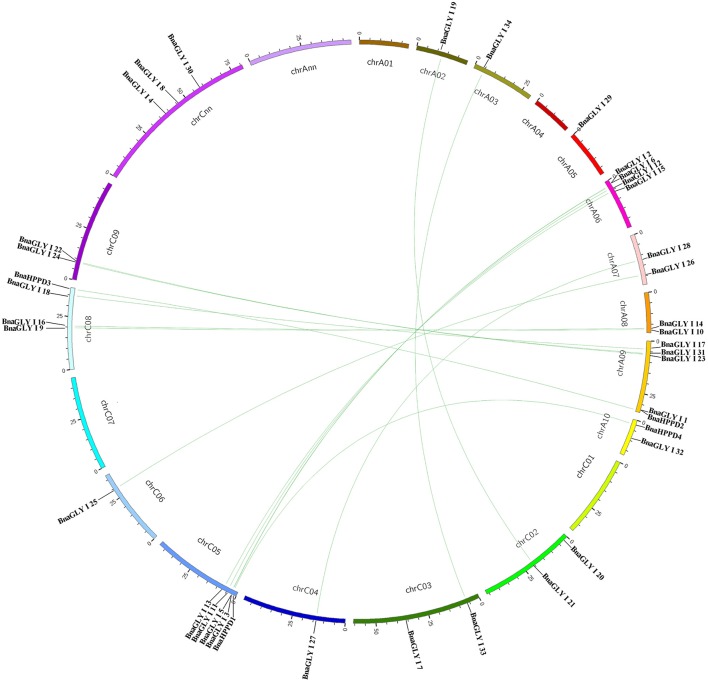
Distribution of BnVOC gene family members on B. napus chromosomes. The BnVOC genes that chromosomal information was available in the database were mapped to the B. napus chromosomes and synteny relationship were lined.